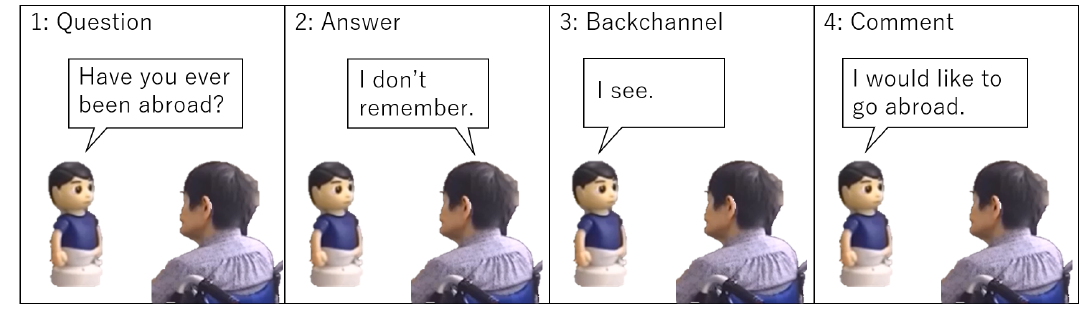
Figure 1. Dialogue constructed from the four